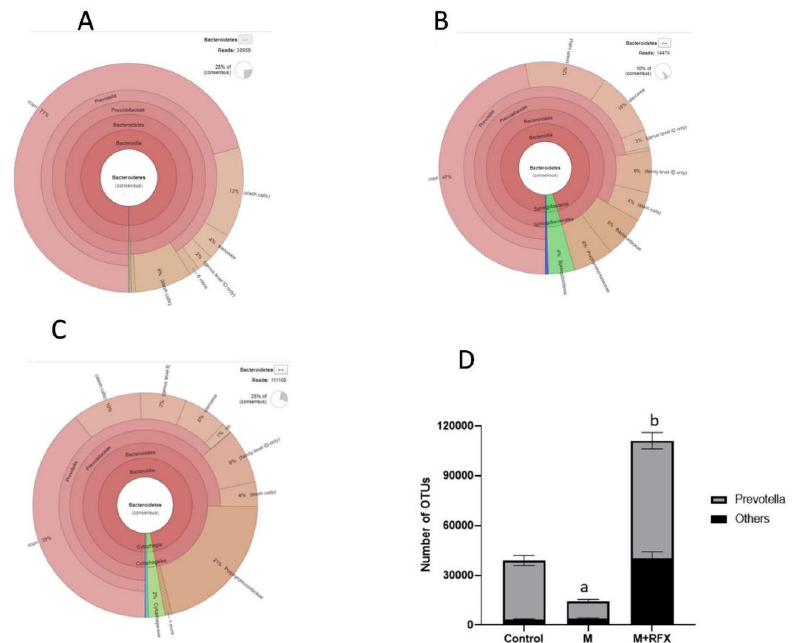
Figure 7. Changes in bacterial genus Prevotella of the phylum Bacteroidetes after RFX intervention in rats exposed to malathion for four weeks. Krona charts showing the genus Prevotella in the control group ( A ), malathion group ( B ), and malathion+rifaximin group ( C ). ( D ): Representative stacked column for the number of OTUs of the significantly changed bacterial genus Prevotella of the phylum Bacteroidetes in the three rat groups. Data are presented as the means ± SEM. a, significant ( p < 0.05) versus control; b, significant ( p < 0.05) versus the malathion group; data were analyzed with one-way ANOVA followed by Bonferroni.